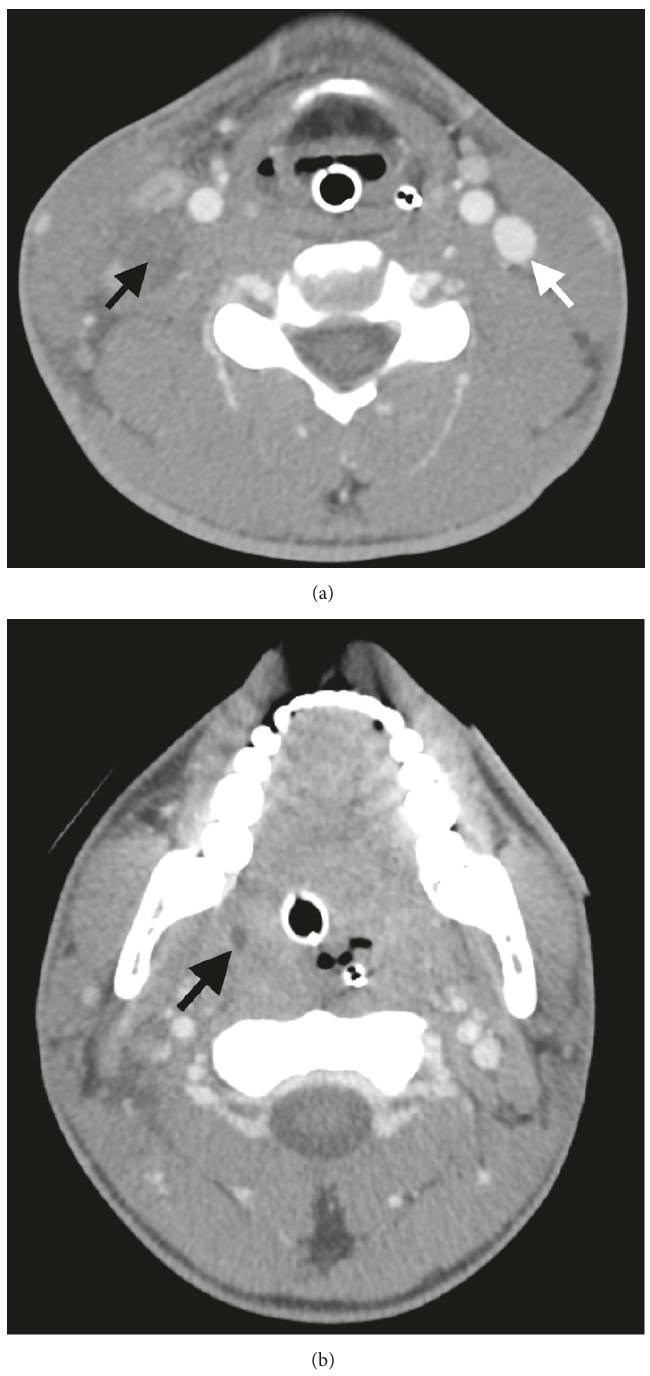
Figure 2: Axial image from CT scan of the neck with intravenous contrast. (a) There is complete occlusion of the right internal jugular vein (black arrow). The left internal jugular vein is patent (white arrow). A small amount of hypodense fluid surrounding the occluded right internal jugular vein reflects inflammatory changes. (b) Peritonsillar hypodensity (black arrow) measured up to 0.6 cm and was presumed to be a small abscess. Endotracheal and enteric tubes are